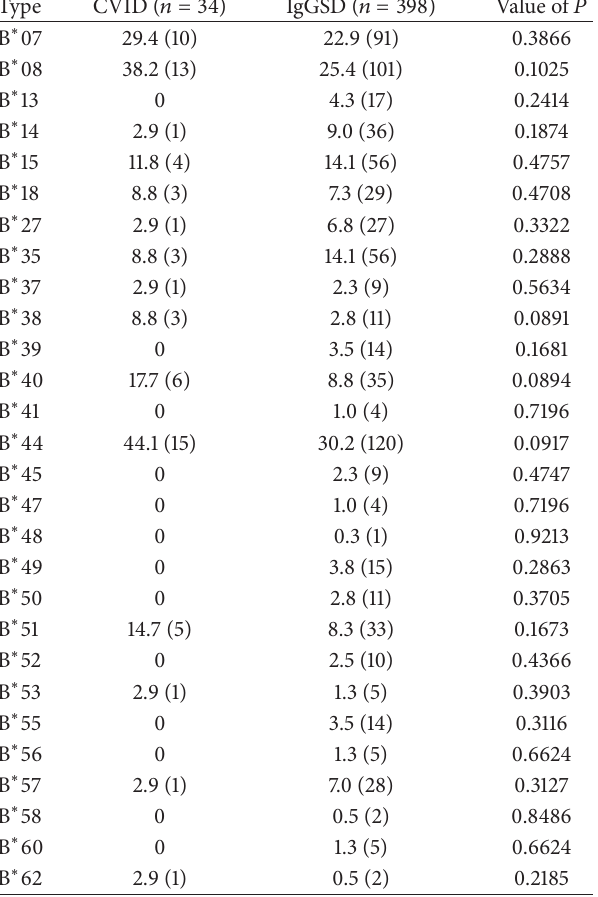
Table 7: Frequencies of HLA-A, -B haplotypes in 432 adult CVID/IgGSD index